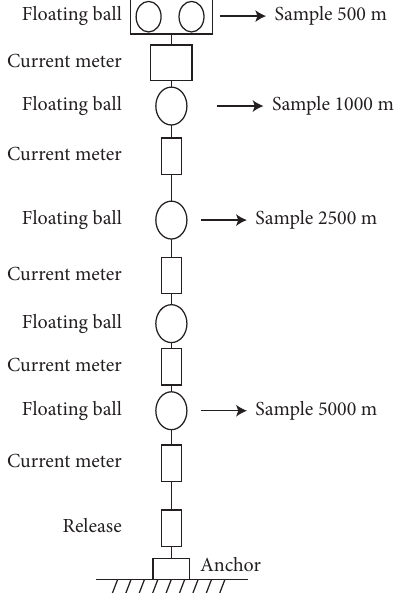
Figure 4: Bunch-style testing system (figure from